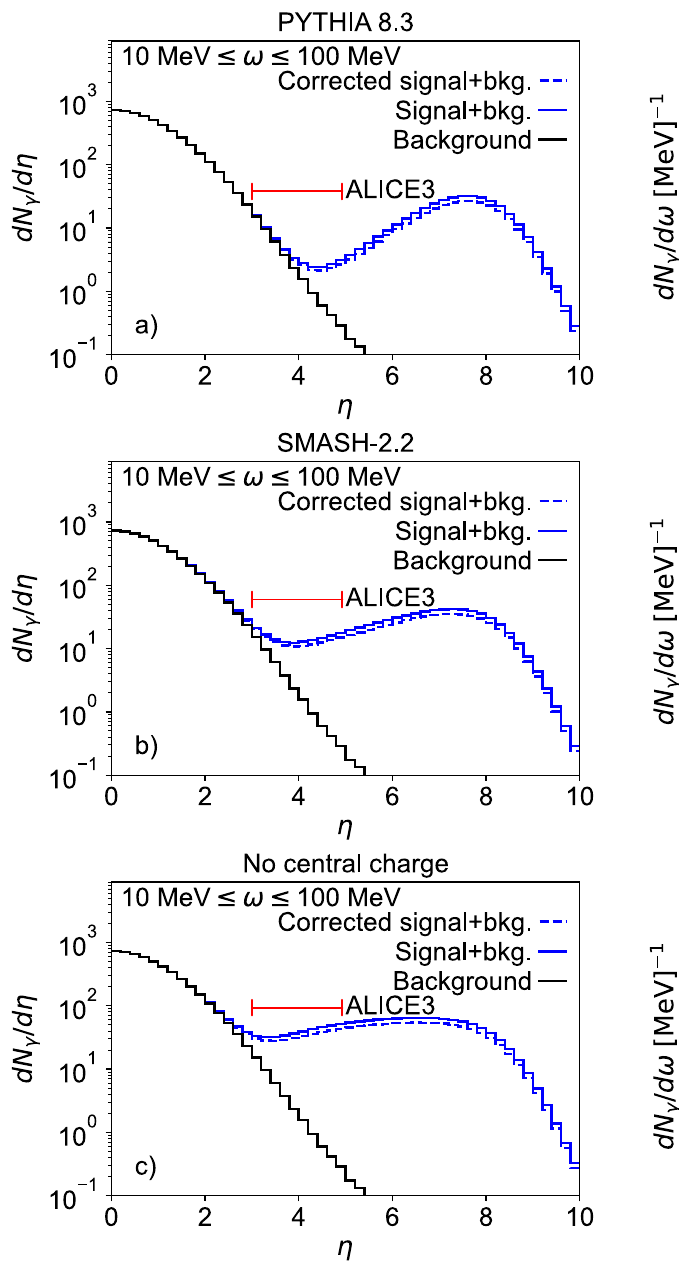
Fig. 5 The energy distributions for photons with 4 . 0 ≤ η ≤ 5 . 0 integrated over the azimuthal angle. The black histogram shows the background from hadronically produced photons. The solid blue his- togram shows the sum of the photons from bremsstrahlung radiation and hadronic production. The correction applied to the bremsstrahlung spectrum to obtain the dashed blue histogram is described in the text. The inset in a) shows the low energy region